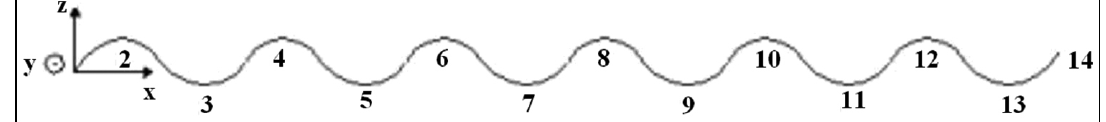
Figure 10. Points in the sheets where verified the maximum stresses: σ